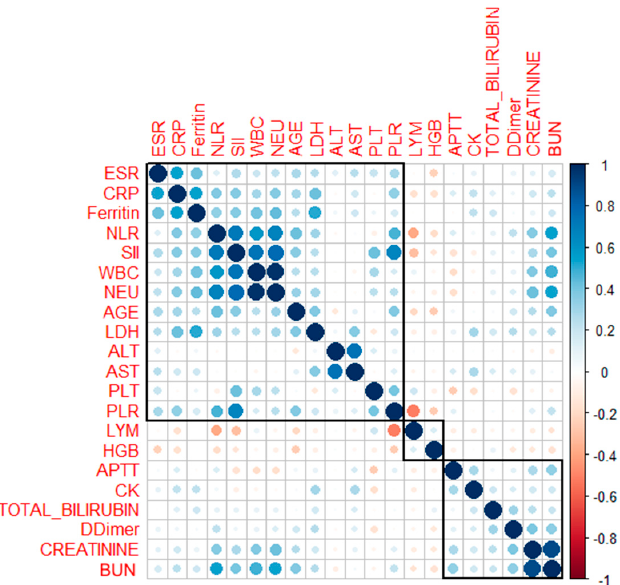
Figure 4. Correlogram with hierarchical clustering of COVID-19 patients. Positive and negative cor-